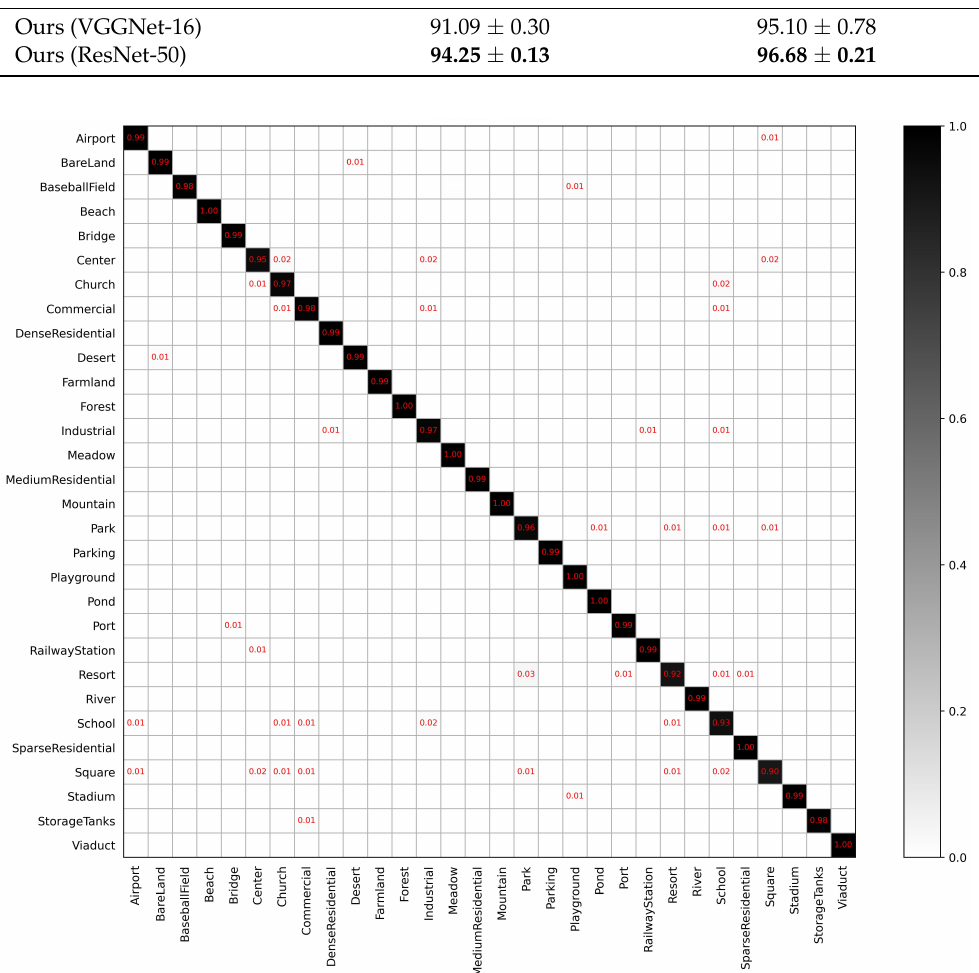
Figure 10. Confusion matrix of the proposed method on the AID dataset with a training ratio of